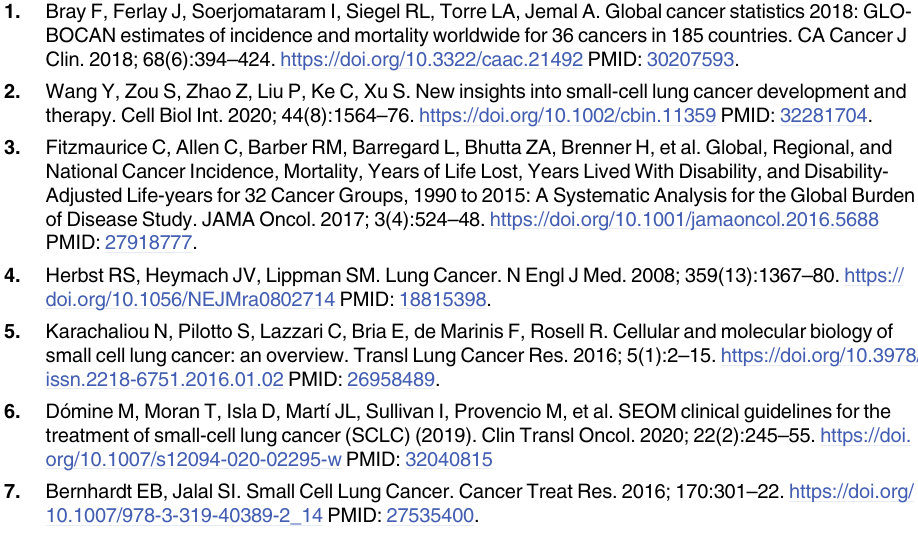
S6 Table. Characteristics of carboplatin/cisplatin + etoposide VP16 first line treatment and response. CR, complete response; PR, partial response; sd, standard deviation; SD, stable disease; PD, progressive disease; NE, not estimated; ND, not determined. S7 Table. Patient characteristics of long-term survivors ( > 2 years; n = 63). CNS, central nervous system; ECOG, Eastern Cooperative Oncology Group.